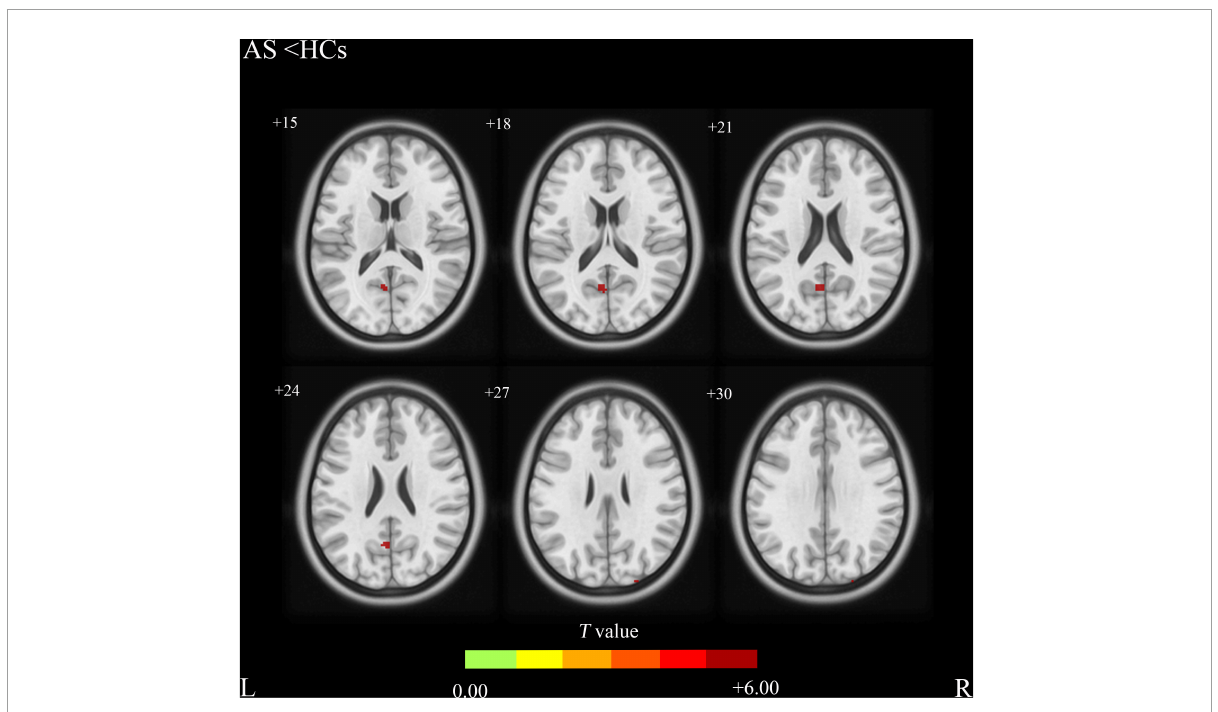
FIGURE2 Ankylosing spondylitis patients showed significantly decreased CBF clusters than HCs (voxel-level correction of FWE). AS, ankylosing spondylitis; HCs, healthy controls; CBF, cerebral blood flow; L (R), left (right) hemisphere; The color bar indicates the T value from the two-sample t -test.